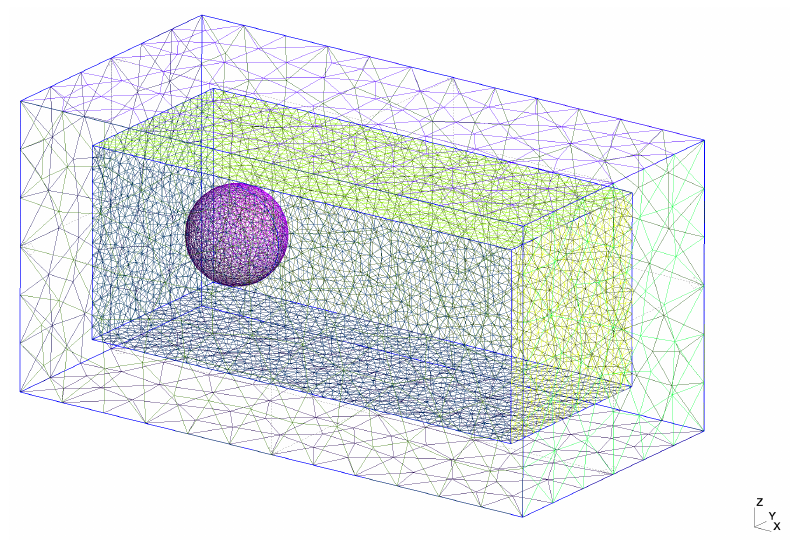
Figure 31. A schematic mesh for solving problems in Section